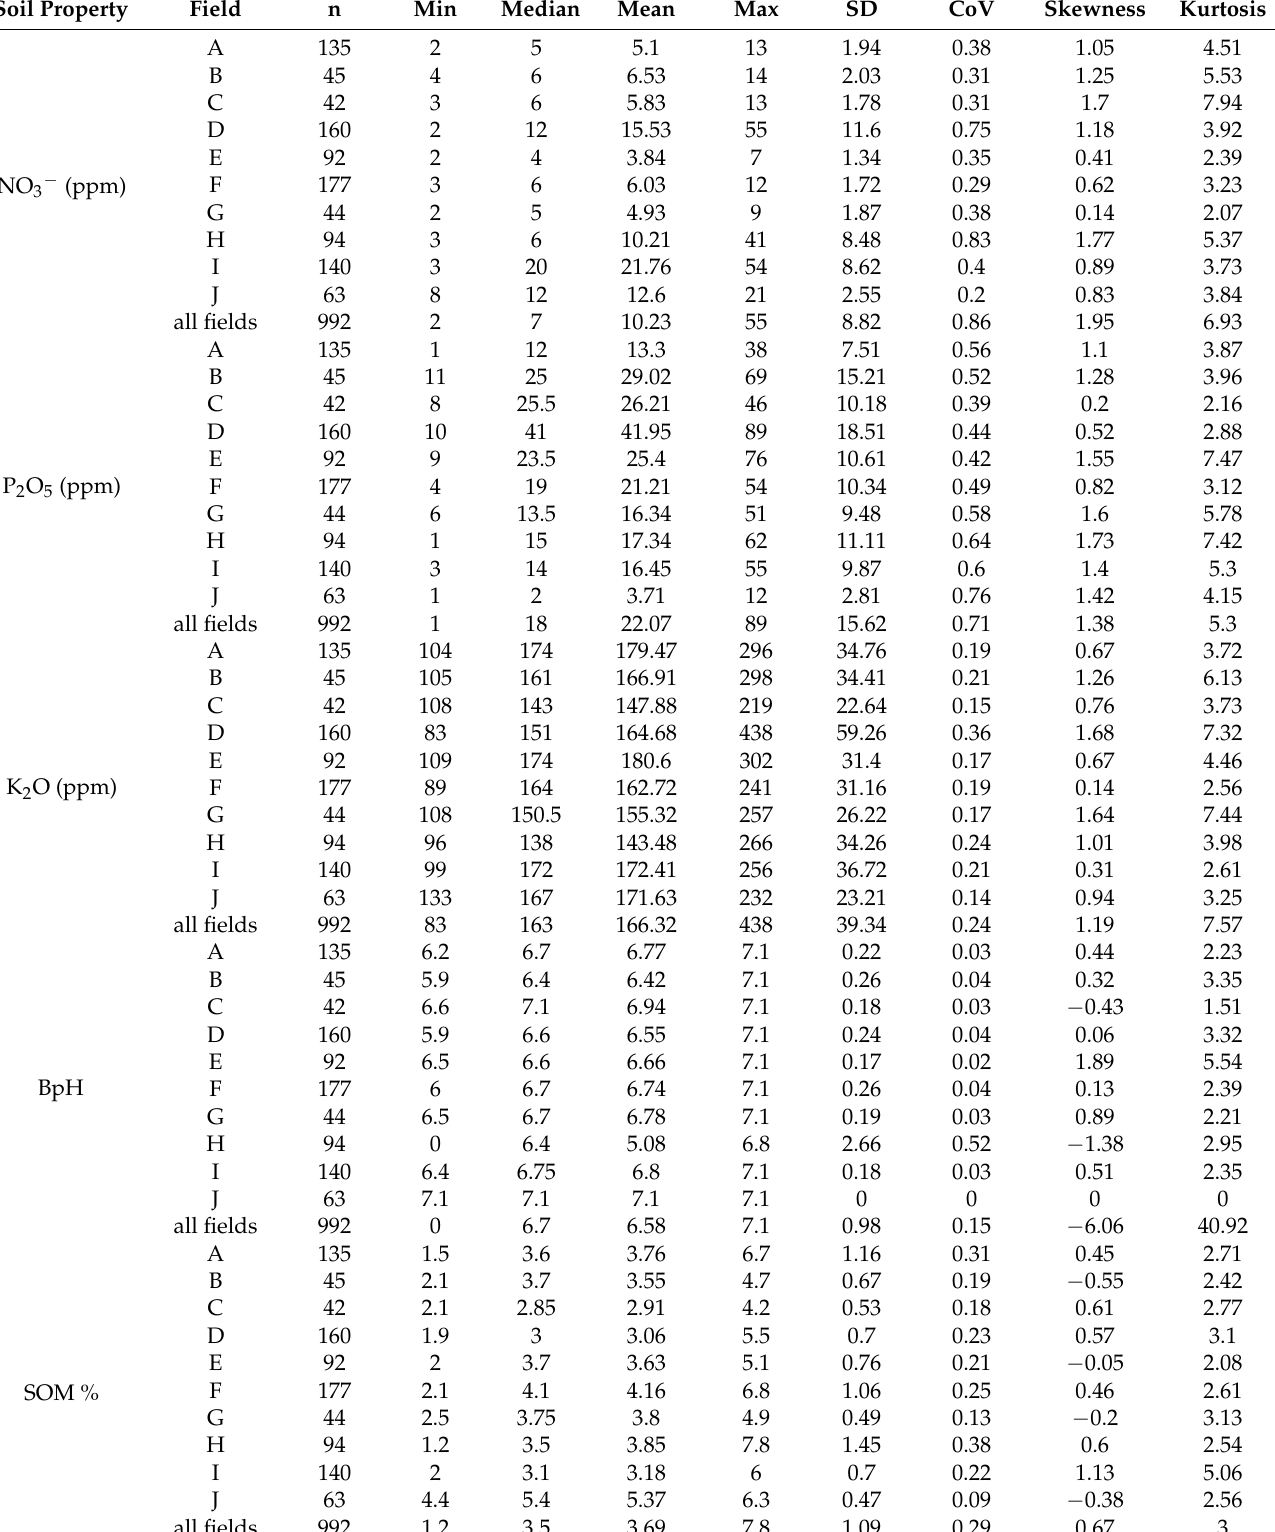
Table 1. Descriptive statistics for NO 3 − , P 2 O 5 , K 2 O, BpH, and SOM by study field and all fields